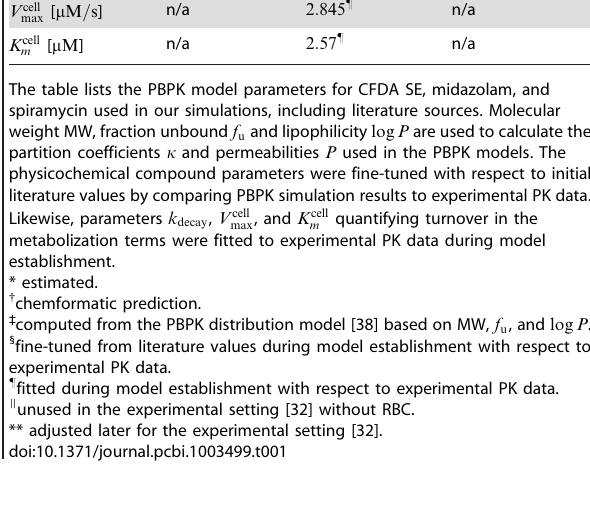
experimental PK data. " fitted during model establishment with respect to experimental PK data. I unused in the experimental setting [32] without RBC. ** adjusted later for the experimental setting